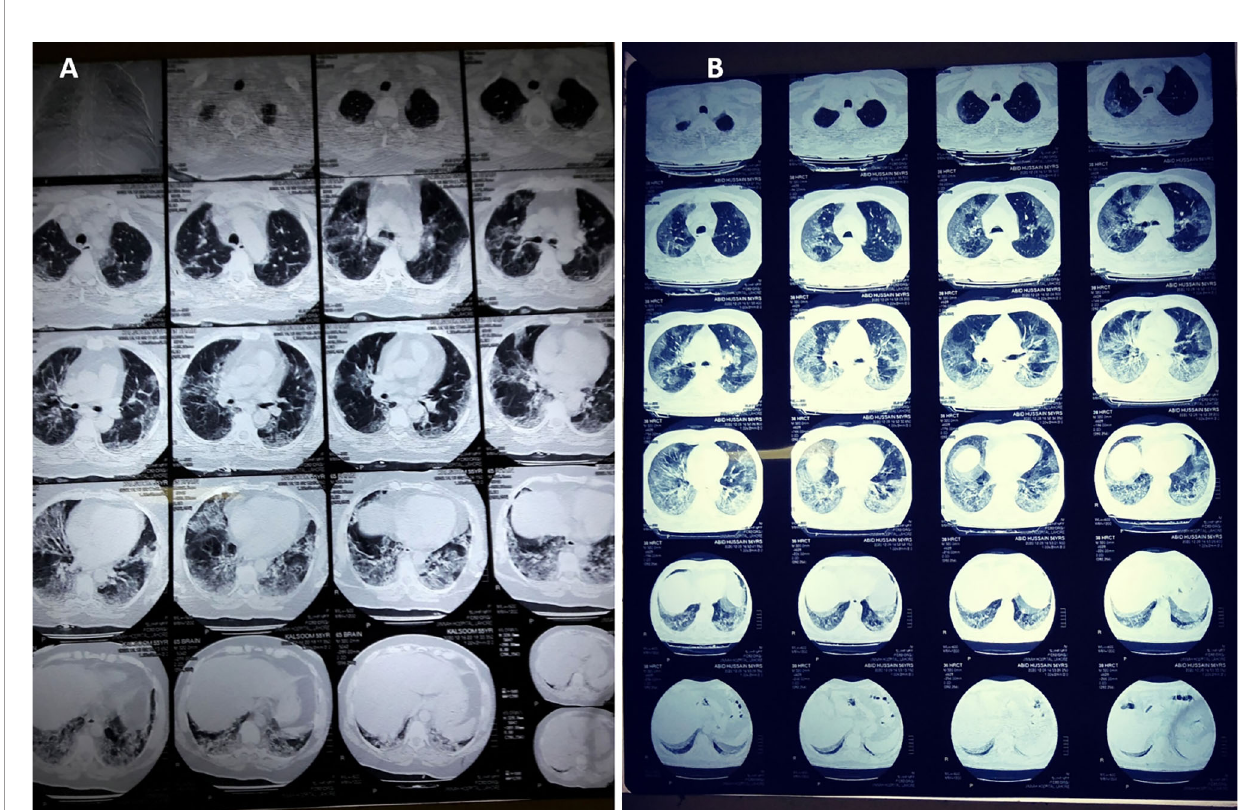
FIGURE 2 | CT scan digital images of (A) mild-to-moderate and (B) severe SARS-CoV-2-infected patients. The percentage of lung involvement can be spotted signi fi cantly in both types of